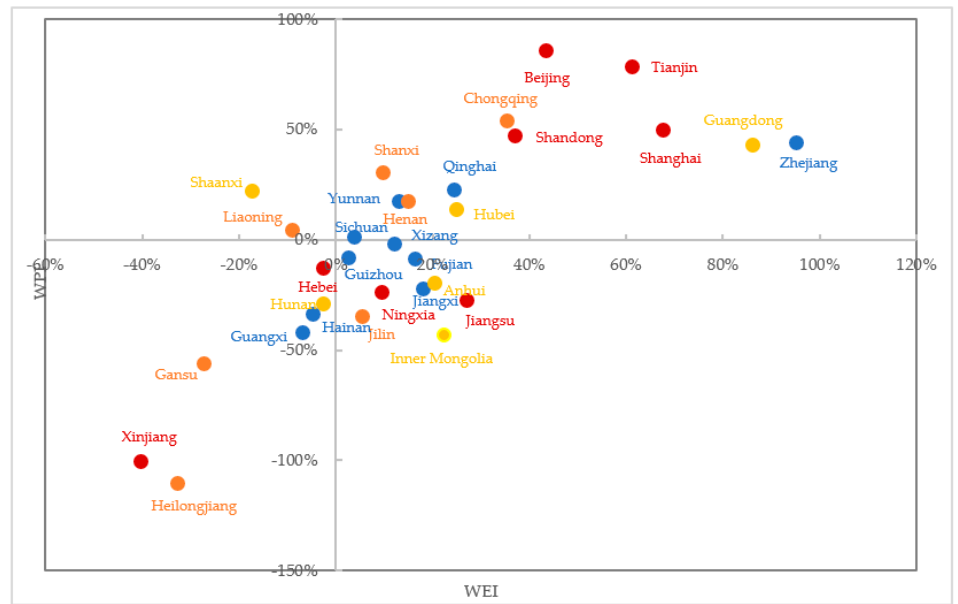
Figure 6. The water plunder index and water-saving efficiency of each province. Note: The points marked in red, orange and yellow indicate that provinces are under extreme, severe, and moderate water shortage, respectively; the points marked in blue indicate that there is no water shortage.